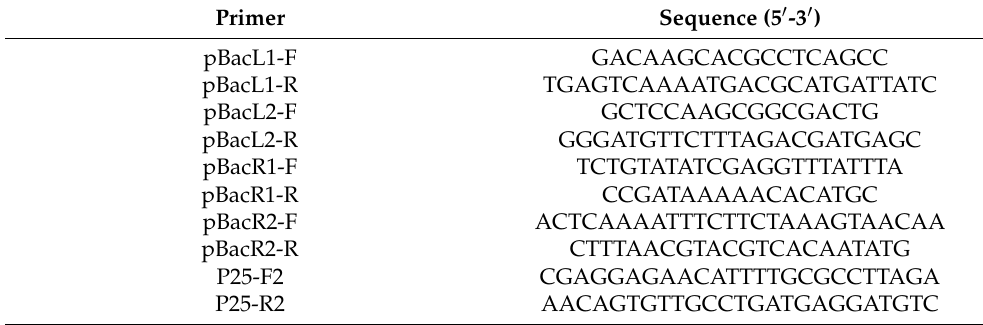
Table 2. List of the primer